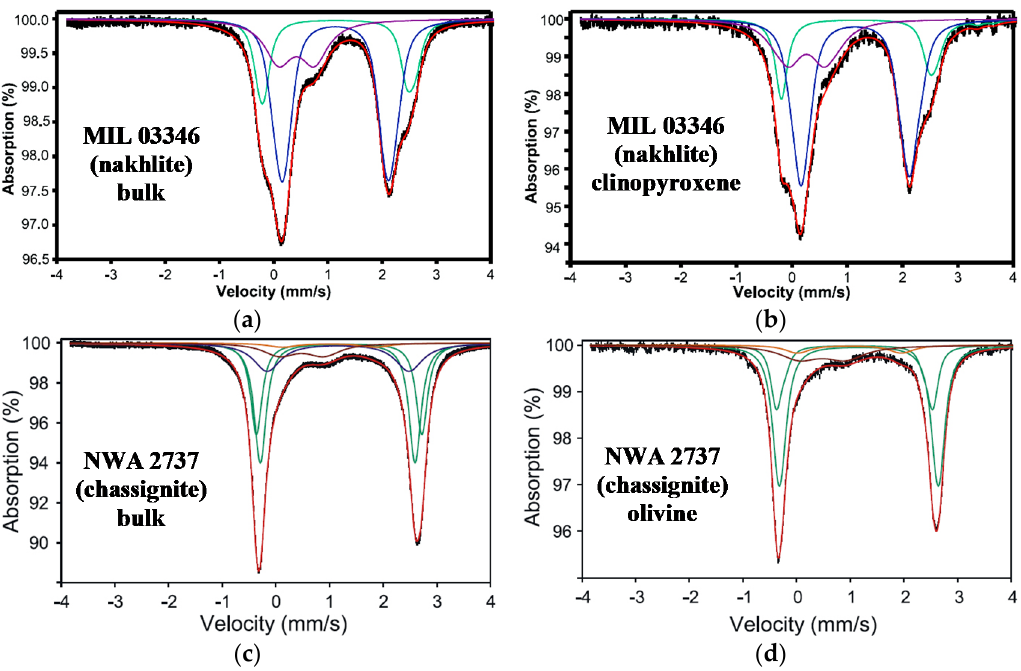
Figure 12. Room temperature Mössbauer spectra of the MIL 03346 and NWA 2737 SNC meteorites: bulk material ( a , c ), extracted MIL 03346 clinopyroxene ( b ), and extracted NWA 2737 olivine ( d ). Indicated components are the results of the fits. Adapted from [29,30].